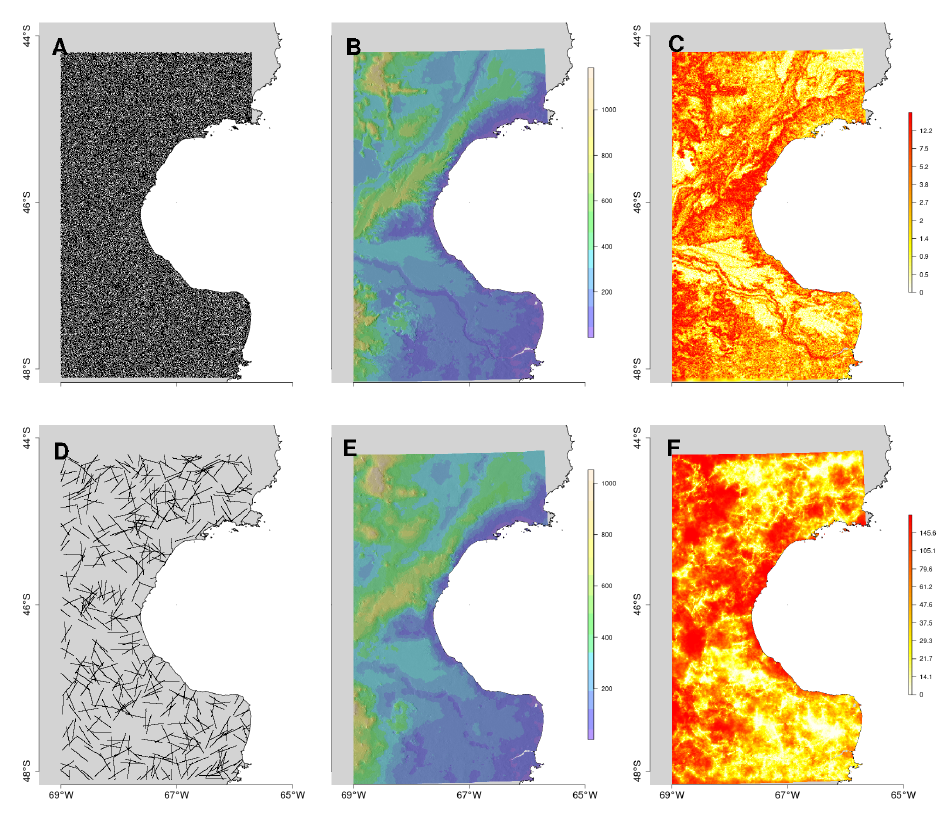
Figure 2. ( A ) Random points used to sample SRTM90 with with p = 0.0156; ( B ) Interpolated DEM ( ˆ f CV ) from point samples; ( C ) K -fold cross-validation standard error ∆ ˆ f CV . ( D – F ) Same meaning, respectively, but using transect